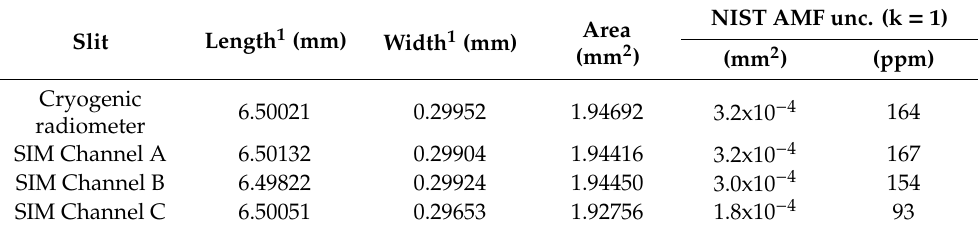
Table 5. SRF cryogenic radiometer and TSIS SIM entrance slit measurements from NIST